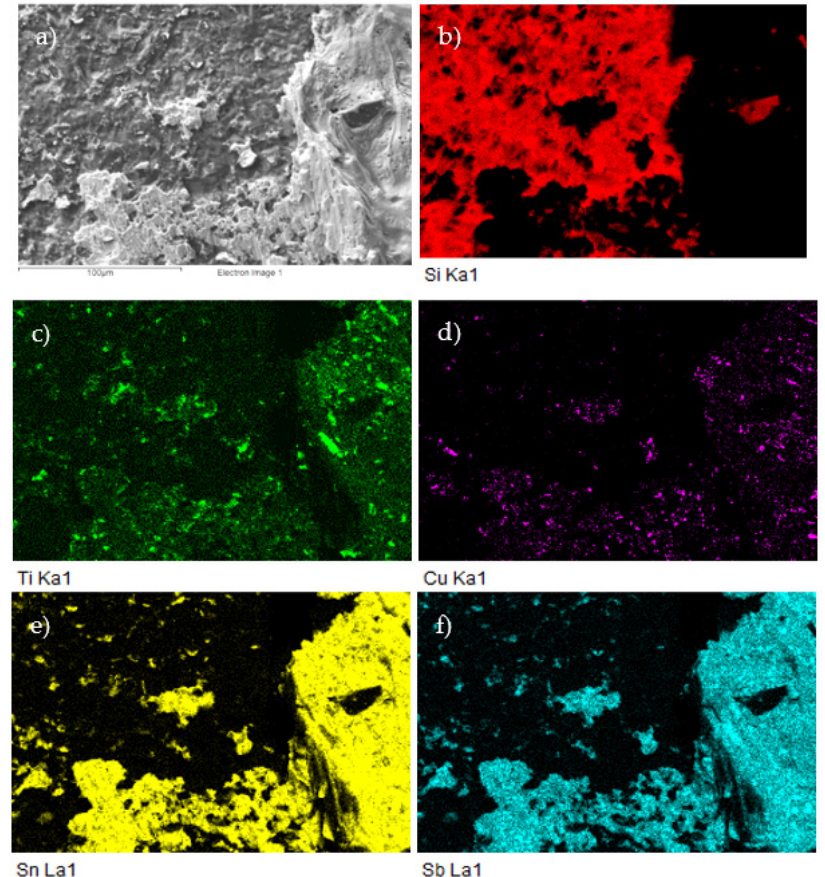
Figure 26 . The fractured surface of the soldered joint of SiC/Sn5Sb3Ti/Cu–SiC and the planar distribution of individual elements; ( a ) fracture morphology; ( b ) Si; ( c ) Ti; ( d ) Cu; ( e ) Sn; ( f ) Sb .